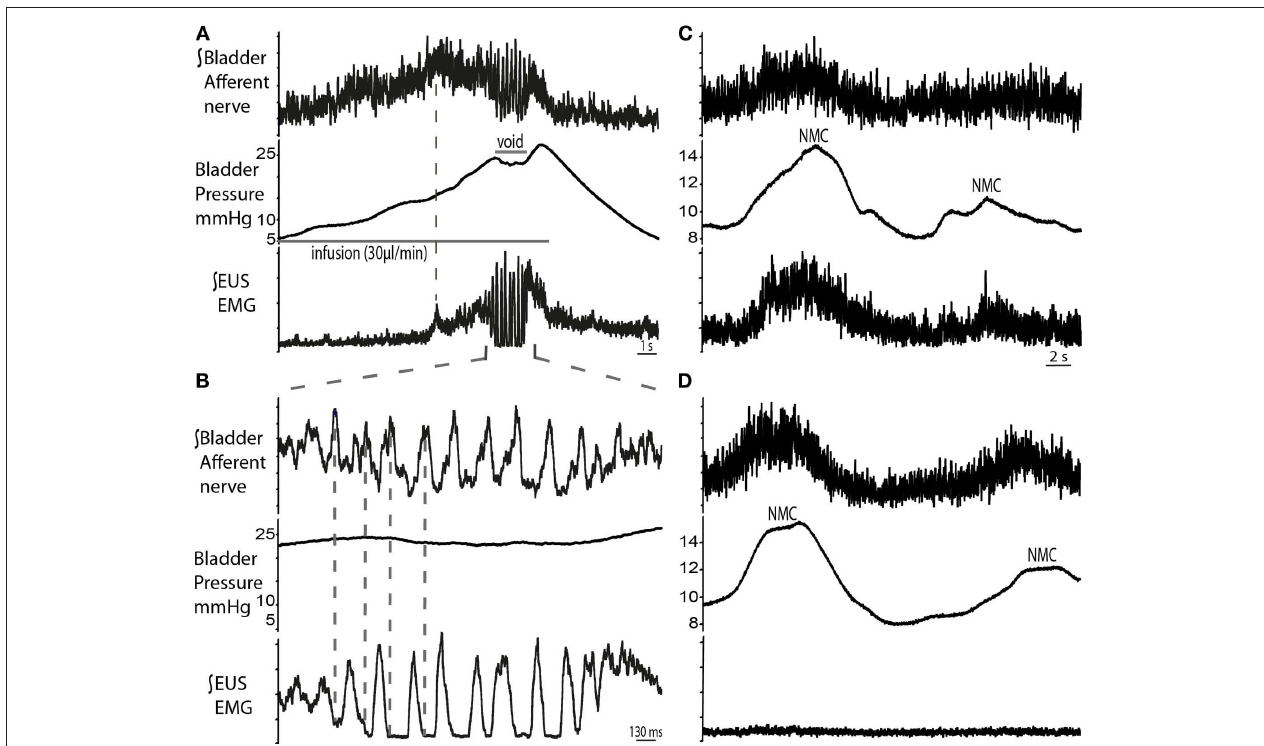
[expanded in (B) ]. (C) Changes in bladder pressure during NMCs were associated with increase in both, EUS–EMG and afferent nerve discharge. To ascertain that this was a nerve response, muscle relaxant was applied (vecuronium dose 2 μg/ ml, systemically) (D) , which resulted in complete abolition of EUS activity, while afferent activity remained on the pelvic nerve in synchrony with the